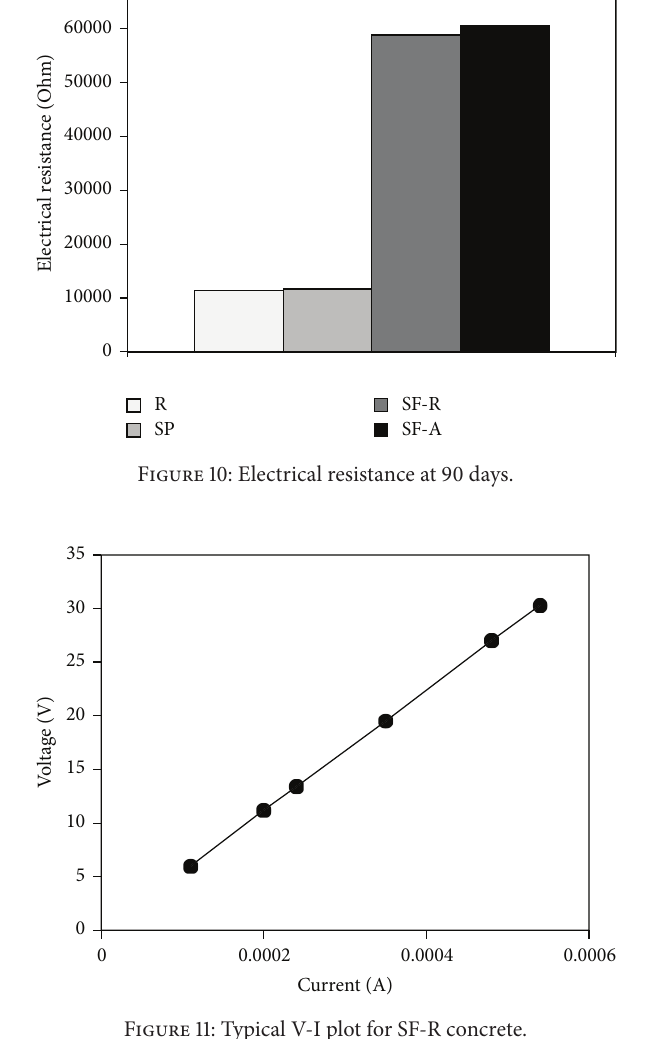
Figure 11: Typical V-I plot for SF-R concrete.